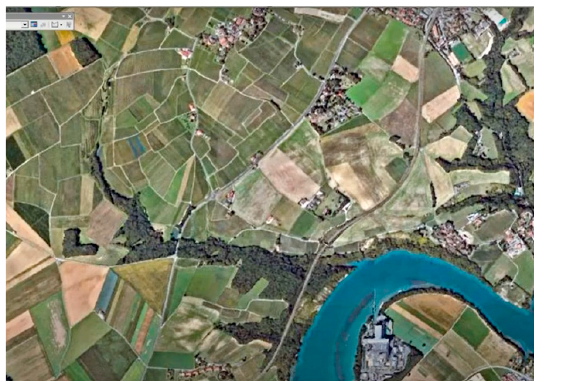
Figure 1. Classification of impervious surfaces using the SVM machine learning method (source: own elaboration based on orthophoto maps available on Geoportal—https://www.geoportal.gov.pl/, accessed on 2 November 2022).